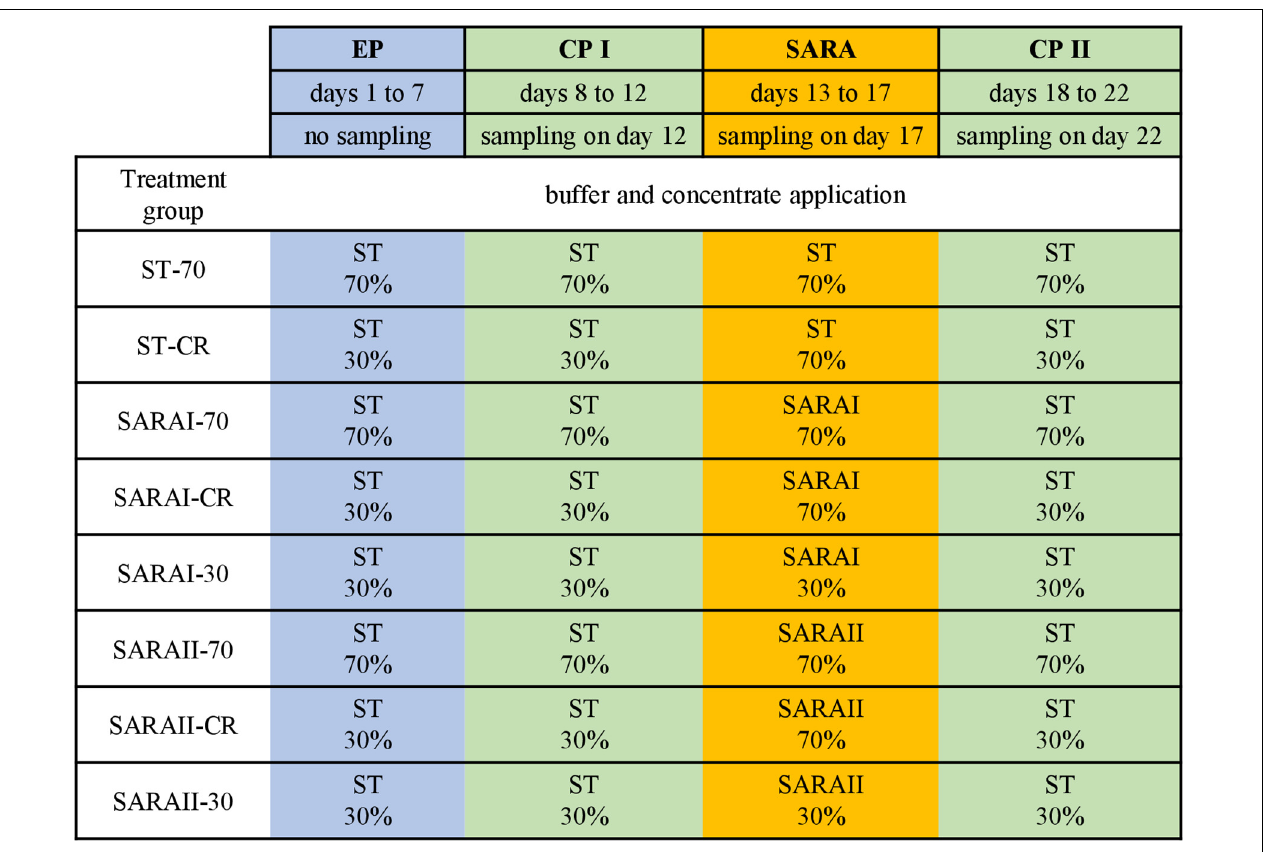
FIGURE 1 | The RUSITEC experiment consisted of an equilibration period (EP, blue) of 7 days, a first control period (CP I, green) of 5 days, followed by the subacute acidosis period (SARA, 5 days, orange), and the second control period (CP II, 5 days, green). Sampling took place on the last day of CP I, SARA period, and CP II. Treatment groups are labeled as follows: ST-70 = standard buffer, 70% concentrate; ST-CR = standard buffer, changing ratio; SARAI-70 = SARA I buffer, 70% concentrate; SARAI-30 = SARA I buffer, 30% concentrate; SARAI-CR = SARA I buffer, changing ratio; SARAII-70 = SARA II buffer, 70% concentrate; SARAII-30 = SARA II buffer, 30% concentrate; SARAII-CR = SARA II buffer, changing ratio. The buffer and concentrate application for each treatment group during all experimental periods is listed as following: type of buffer (top) concentrate ratio (bottom). The type of buffer is labeled as ST = standard buffer, SARAI = SARA I buffer, SARAII = SARA II